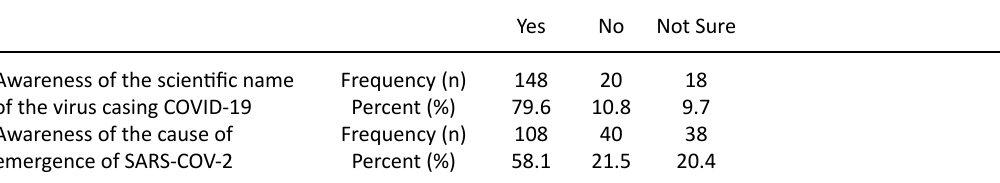
Table 2. Awareness of participants regarding the scientific name of the virus causing COVID-19 and the cause of emergence of SARS-CoV-2 * (n=186).